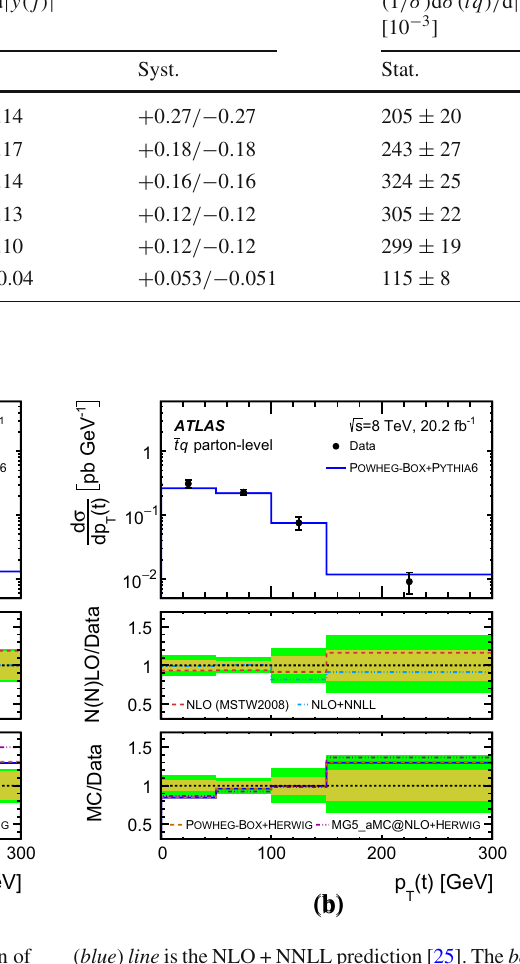
normalised unfolded differential ¯ tq production cross-section as a function of | y ( ˆ j ) | at particle